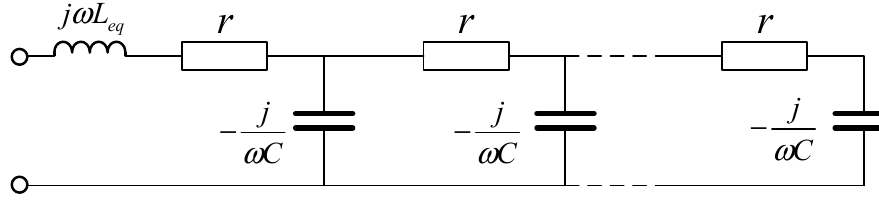
Figure 9. UC equivalent circuit considering the inductivity of connecting wires.